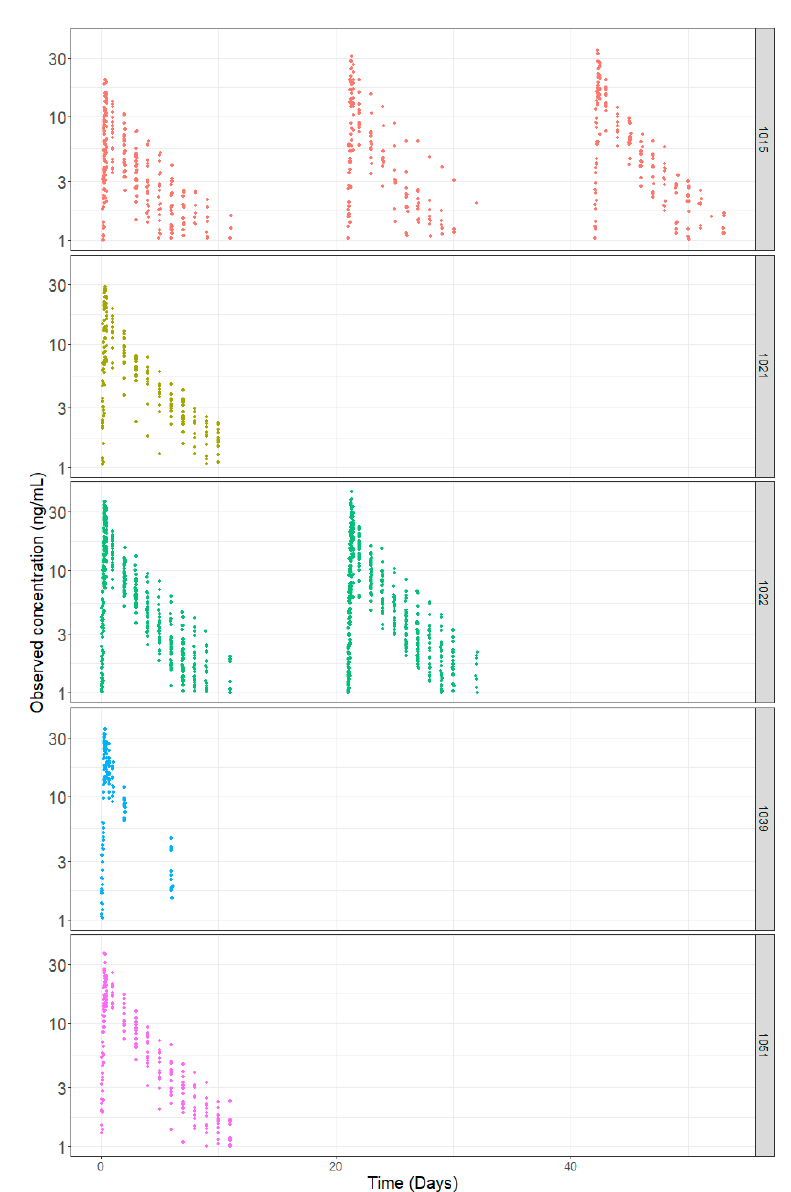
Figure 1. Dacomitinib Concentration-Time Profiles by Study. Table 2. Demographic Characteristics for the Pooled Dataset of Dacomitinib Studies.